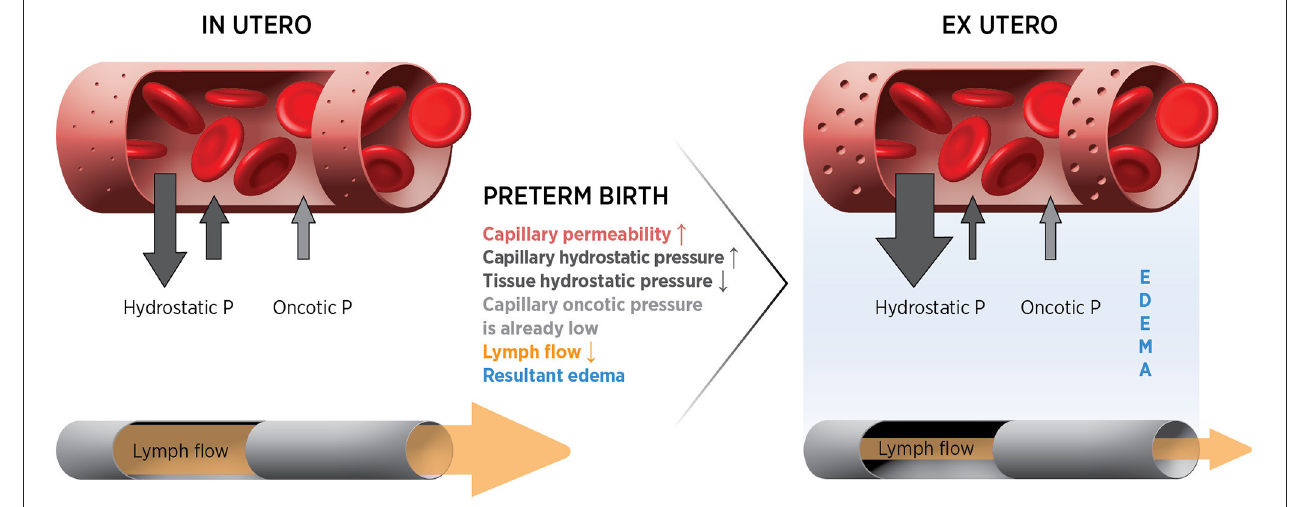
FIGURE 3 | Forces and potential changes affecting fluid movements at the capillary after preterm birth.